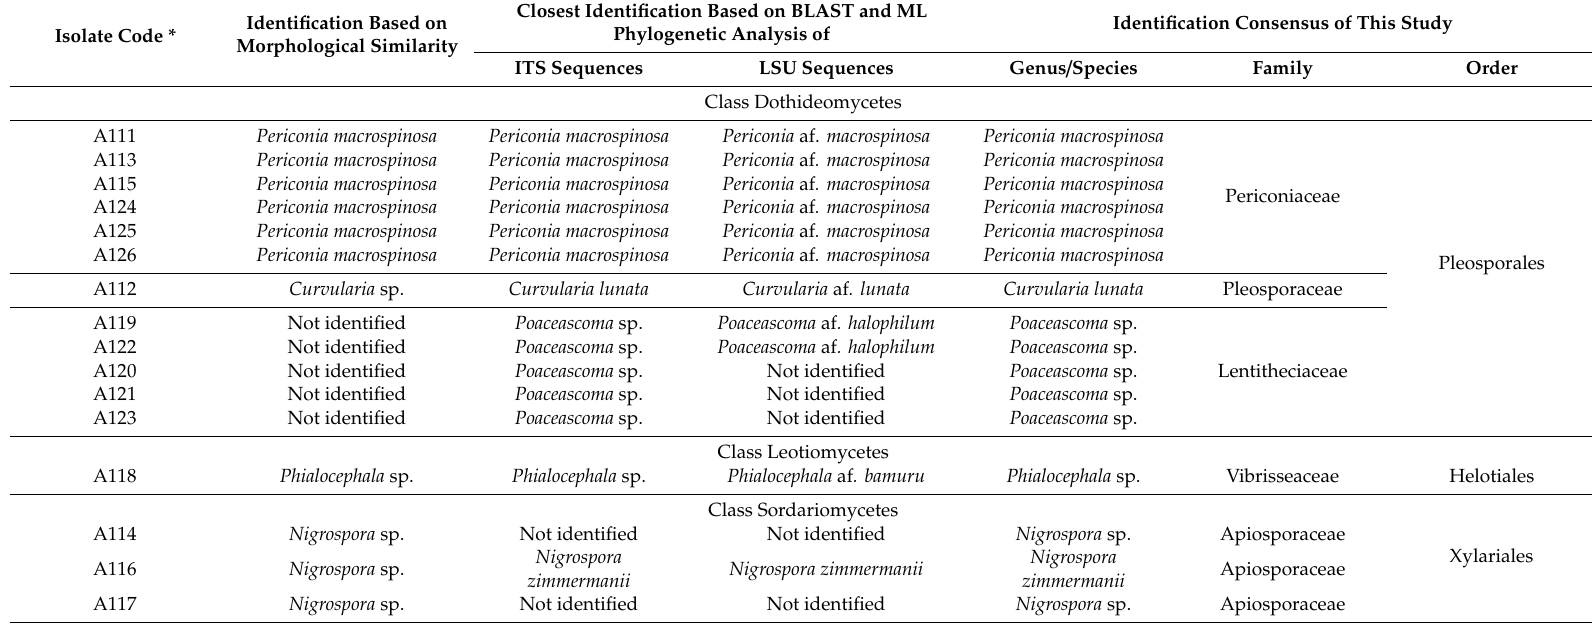
Table 3. Identification of the dark septate endophytic fungi isolated from roots of sugarcane sampled in the producing region of Quat á , S ã o Paulo, Brazil. ITS, internal transcribed spacer; LSU, large subunit; BLAST, Nucleotide Basic Local Alignment Search